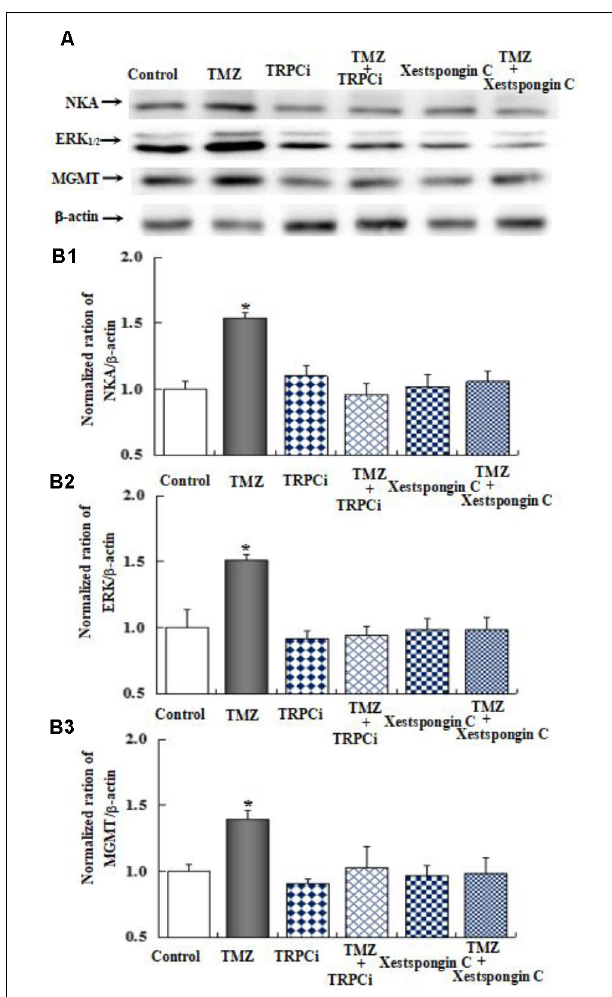
FIGURE 10 | The upregulation of TMZ-induced Na,K-ATPase, ERK 1 / 2 , and MGMT expression by TRPC1 and IP3R in U251 cells. (A) Cells were incubated for 48 h in the absence of any drug (Control) or in the presence of 5 µ M TMZ. In some experiments 2 µ g/mL TRPC1 neutralizing antibody (TRPCi) and 1 µ M Xestspongin C were added 4 h before the addition of TMZ. (B1) Mean Akt expression was quantified as ratios between Akt and β -actin. (B2) Mean ERK 1 / 2 expression was quantified as ratios between ERK 1 / 2 and β -actin. (B3) Mean MGMT expression was quantified as ratios between MGMT and β -actin. Similar results were obtained from three independent experiments. SEM values are indicated by vertical bars. ∗ Indicates a statistically significant ( P < 0.05) difference from the negative control group.